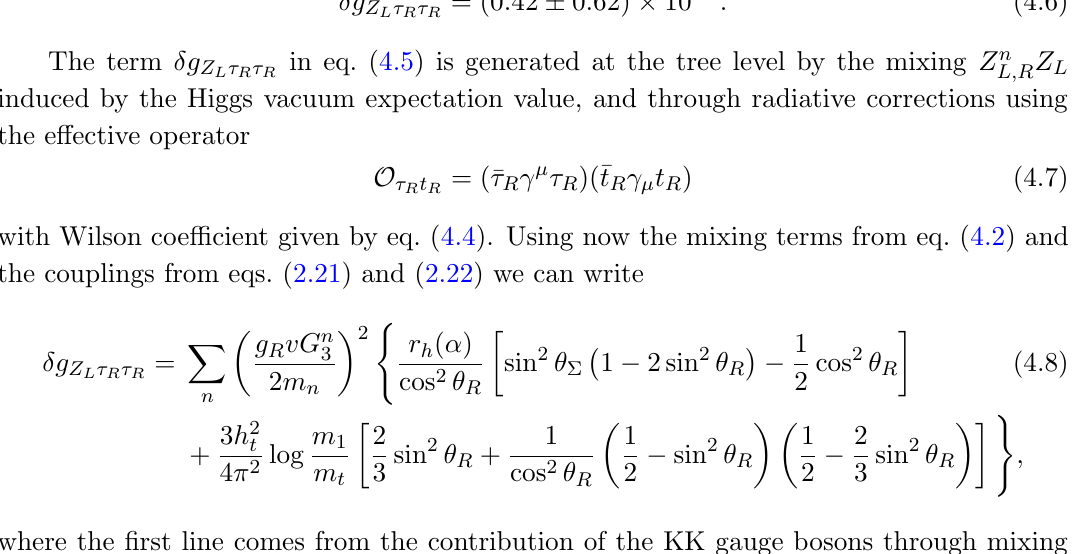
Figure 2 . The region between the (brown) solid lines is allowed by the best (cid:12)t to (cid:14)g Z m 1 = 3